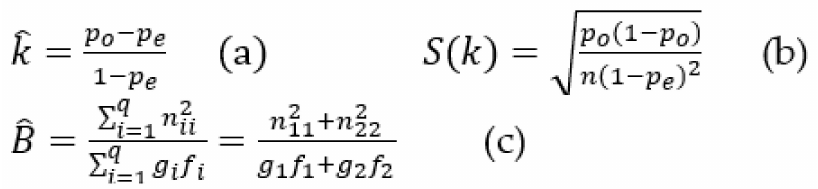
Figure 3. Kappa and B statistic calculation formulas. Legend: where n is the total number of observations, n ii is the n 11 and n 22 representing the number of agreements between hospital and WtsWrng; g i is the g 1 and g 2 representing the total diagnoses identified and not identified by the hospital; f i is the f 1 and f 2 representing the total diagnoses identified and not identified by WtsWrng; p o is the proportion of the observed agreements between the hospital and WtsWrng ( n 11 + n 22 ) / n ; and p e is the expected agreements ( g 1 g 2 + g 2 f 2 ) / n 2 assuming independence between the assessment of hospital and